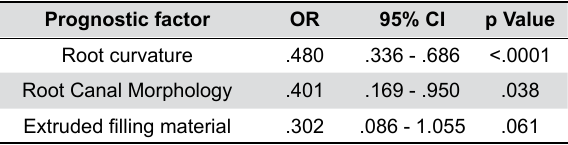
Prognostic factor